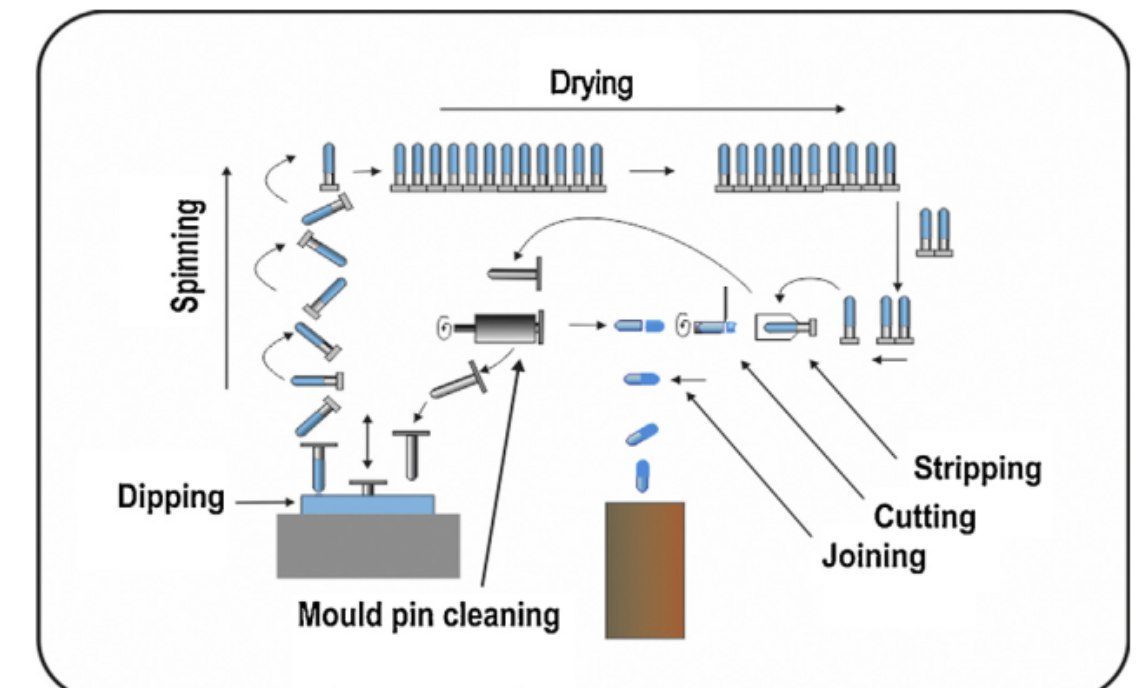
Figure 7. Hard capsule manufacturing. Reproduced with the permission from [120], Elsevier, 2016.